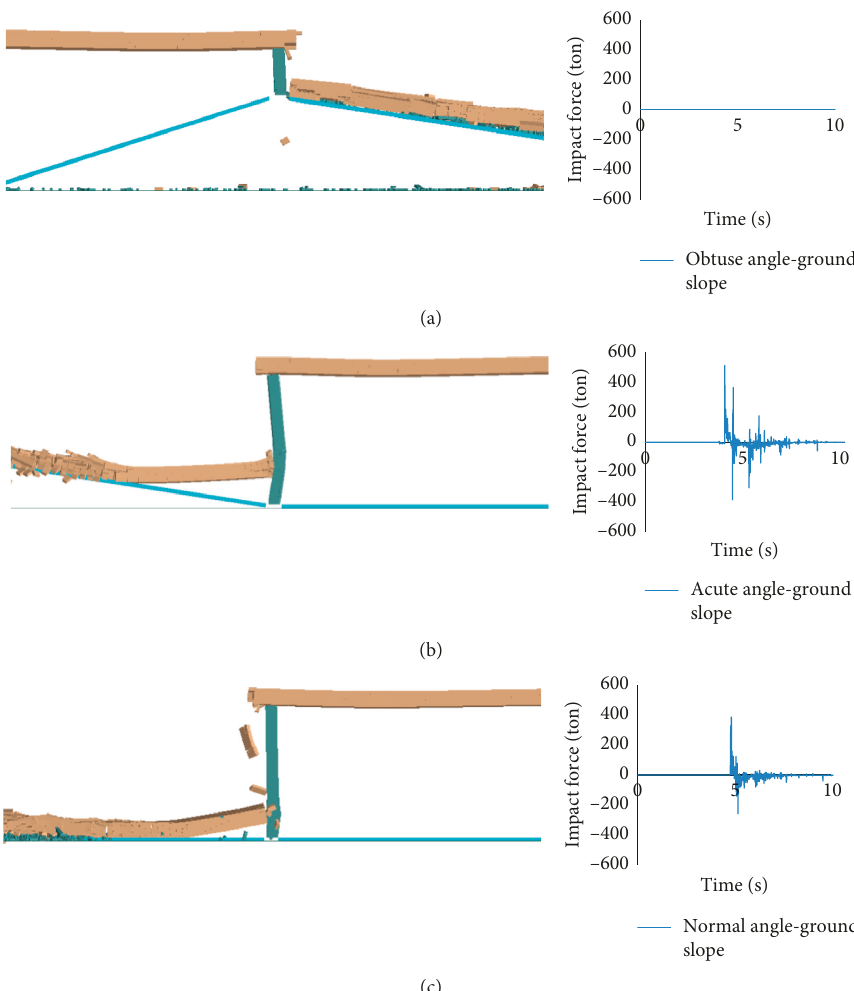
Figure 23: Effect of ground slope on impact possibility and collapse propagation: (a) obtuse angle, (b) acute angle, and (c) normal